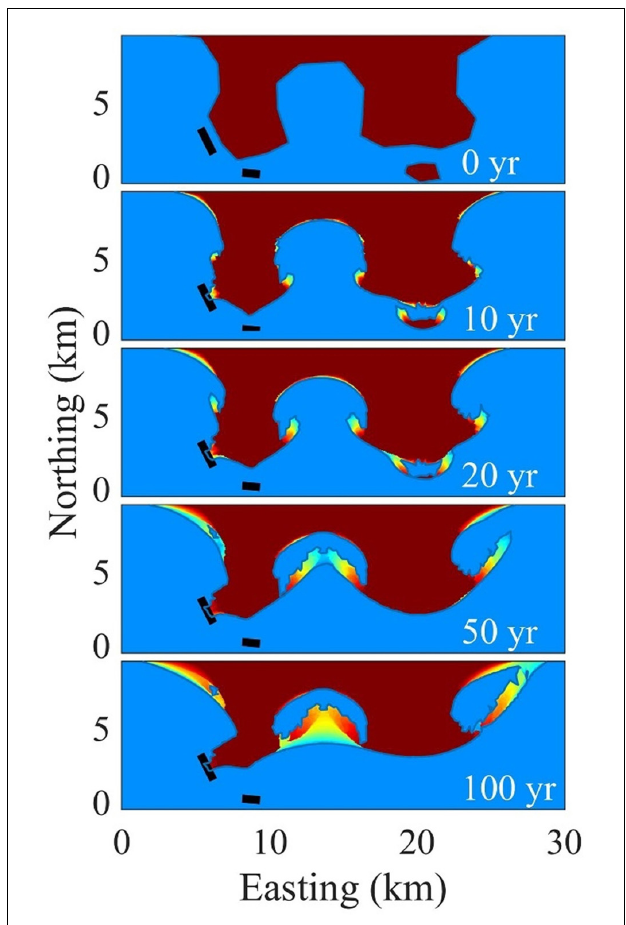
FIGURE 10 | Evolution of coastal features in a geometry resembling van Rijn’s overview of coastal shapes. Colors indicate age of deposition, with green the most recent deposition to dark red for the oldest